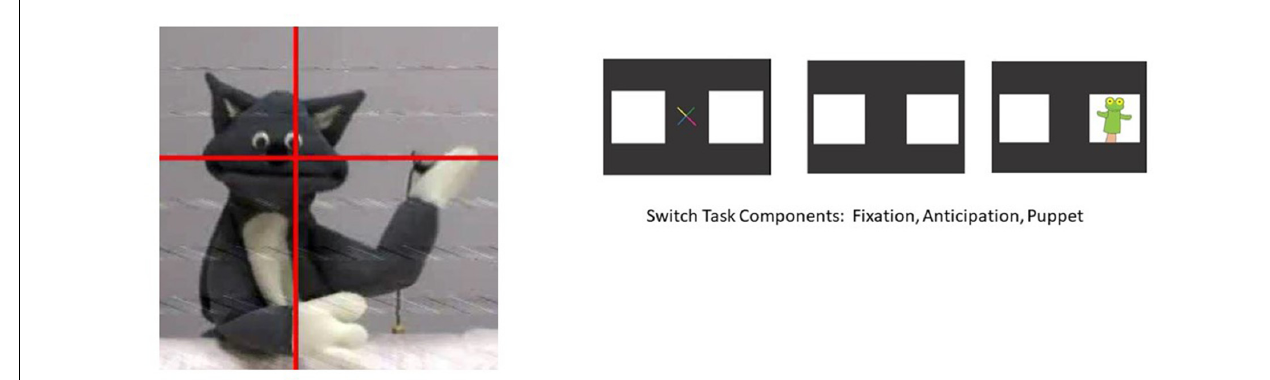
FIGURE 2 | The cat puppet and switch task.